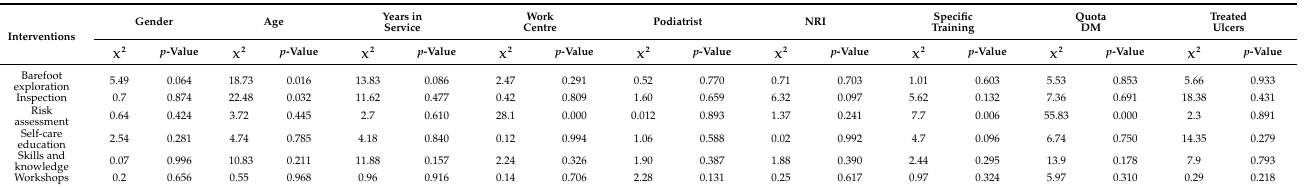
Table 6. Chi 2 ( χ 2 ) analysis between the characteristics of the population and the activities carried